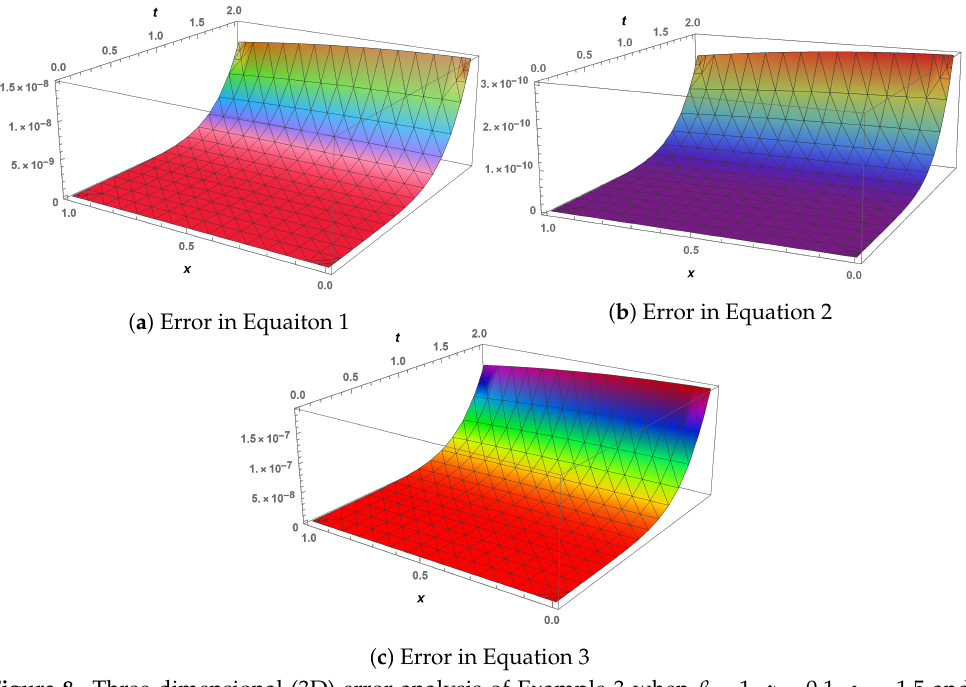
Figure 8. Three-dimensional (3D) error analysis of Example 3 when β = 1, α = 0.1, c 0 = 1.5 and c 2 = p = 0.5.